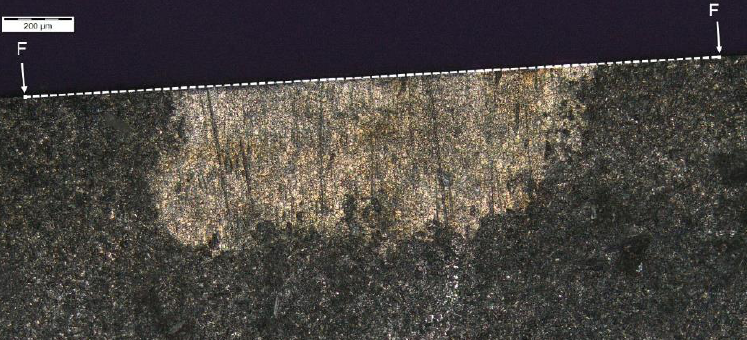
Figure 8. Localization of cross-section F-F, zone: 3A.